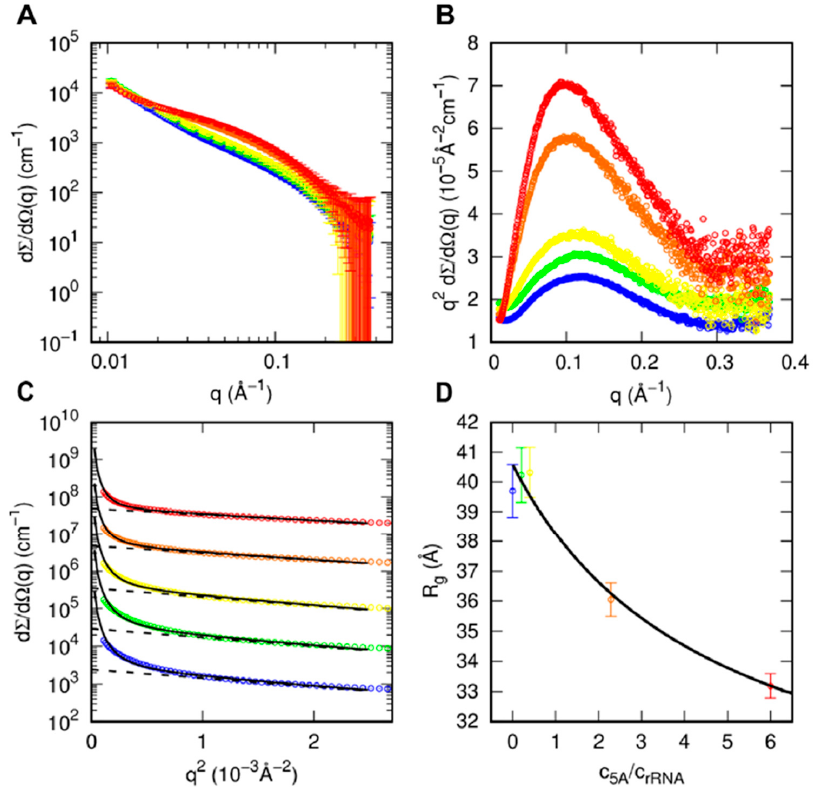
Figure 4. SAXS analysis of N-His-aIF5A in the presence of rRNA at 63 °C: ( A – C ) SAXS curves reported in log–log, Kratky and Guinier plots. The protein and the rRNA concentrations of each sample are: 0 and 2.5 mg/mL (blue); 0.5 and 2.5 mg/mL (green); 1 and 2.5 mg/mL (yellow); 4 and 1.75 mg/mL (orange); 6 and 1 mg/mL (red). These values correspond to the protein/rRNA w / w ratio ranging from 0 to 6. Curves in panel C have been multiplied by a factor 10 for the sake of a better visualization. The solid black lines in panel C are the best Guinier/Porod fits (Equation (S1)), whereas the dashed black lines are the Guinier law contribution (first term of Equation (S1)). ( D ) The obtained radii of gyration as a function of the protein/rRNA ratio. The solid black line is the best fit obtained with Equation